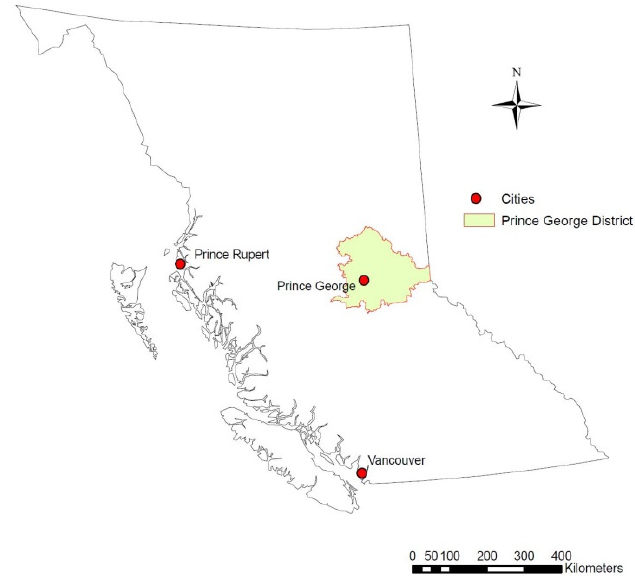
Figure 1. Location map showing the Prince George Forest District within the province of British Columbia.